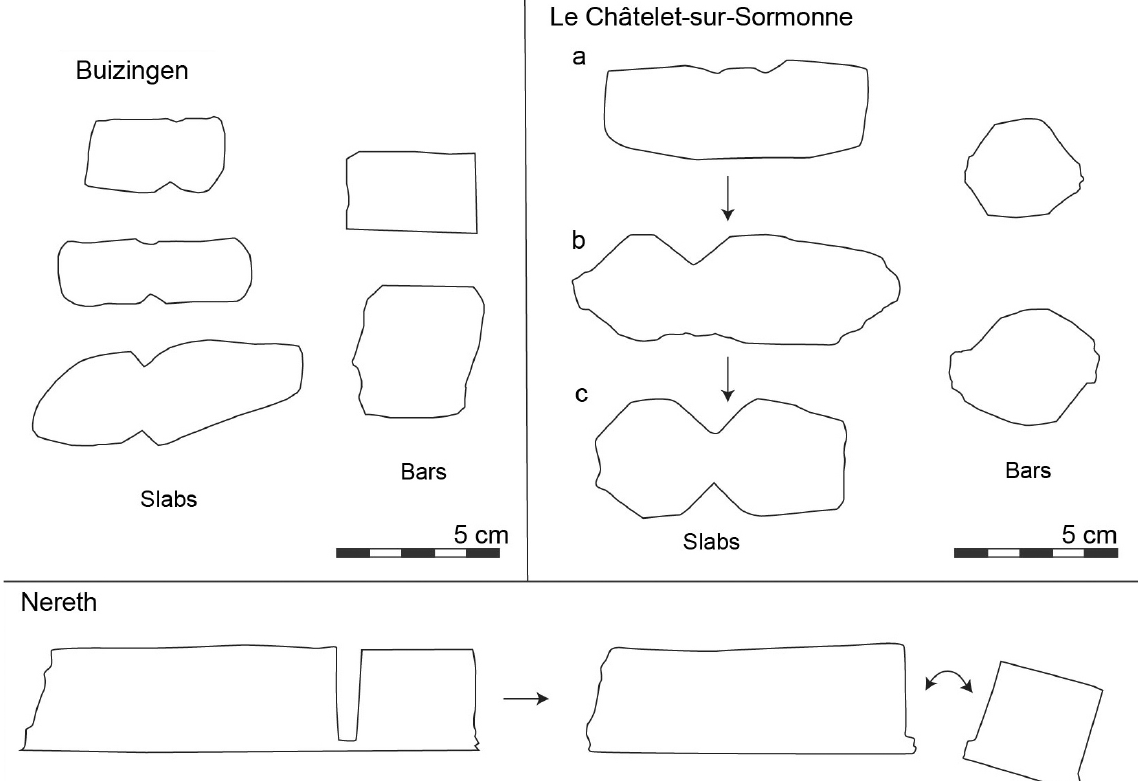
Figure 8: Sections of slabs with grooves and bars cut from slabs. Le Châtelet-sur-Sormonne: a. two narrow grooves are carved on one face, b. the final V-shaped groove is deepened, b and c. the process is repeated on the opposite face. Nereth: sawing reconstruction of a